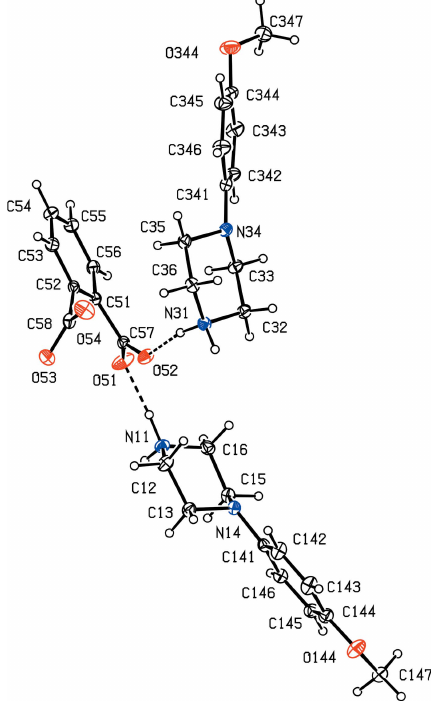
Figure 2 The independent components in the type 1 ion triplet in compound (II), showing the atom-labelling scheme and the hydrogen bonds, drawn as dashed lines, within the selected triplet. Displacement ellipsoids are drawn at the 30% probability level